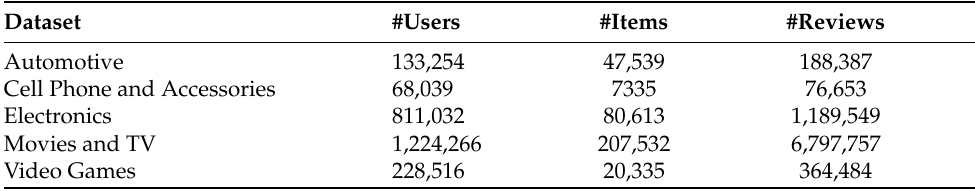
Table 1. A summary of the selected